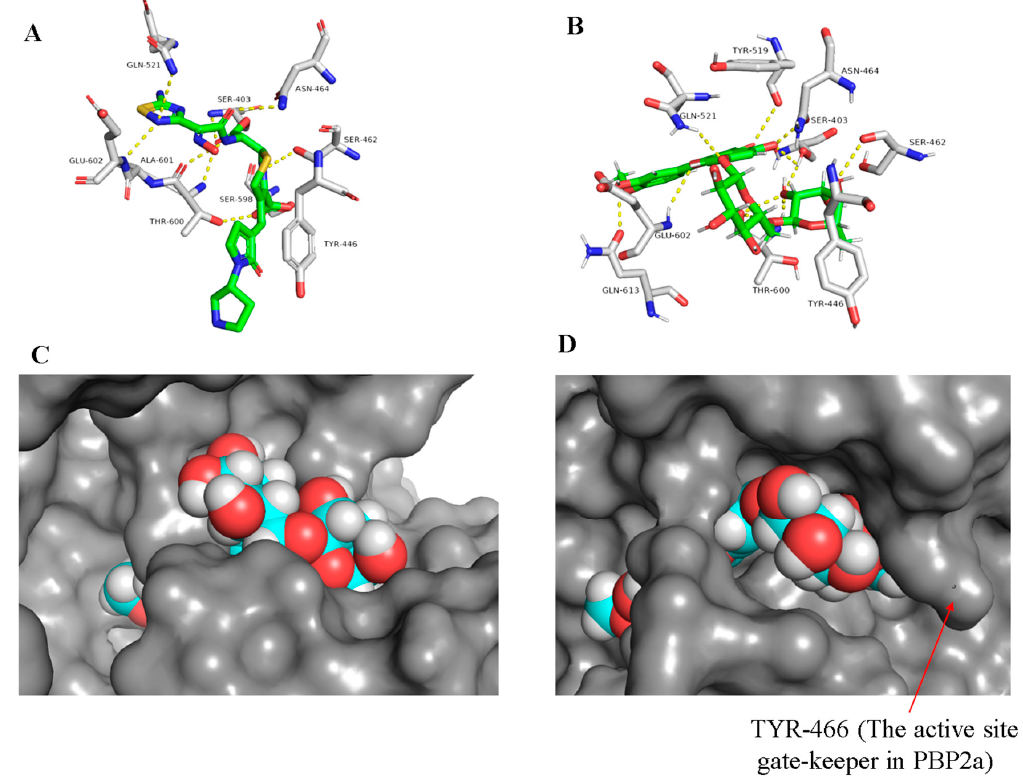
Figure 3. Binding mode of the co-crystalized ligand ceftobiprole (25) and diosmin (11) inside the PBP2a active site ( A and B , respectively), and docking of diosmin (11) inside PBPa and PBP2a ( C and D , respectively) to show the difference between the two proteins in terms of accessibility.